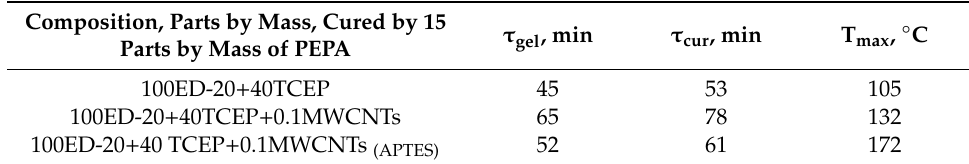
Table 6. Values of the curing process of epoxy composites.